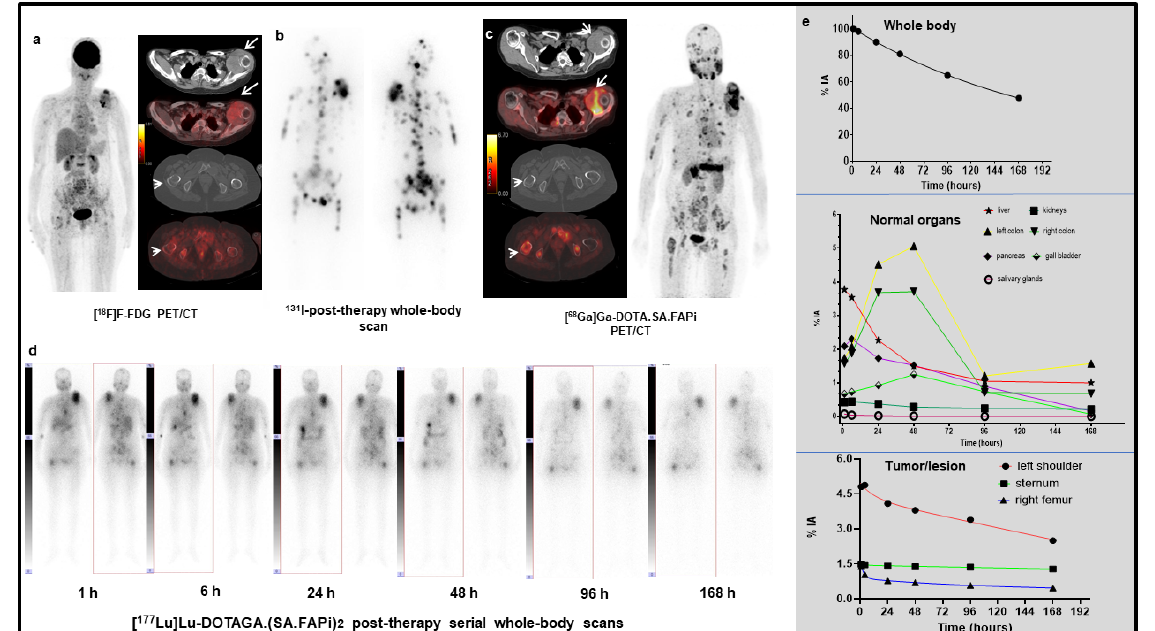
Figure 3. ( a ). [ 18 F]F-Fluorodeoxyglucose (FDG) PET/CT images of a 50-year-old woman with follicular variant of papillary carcinoma, post radioiodine therapy (cumulative dose of 22.2 GBq) showing soft tissue density mass in left shoulder (ar- rows) and multiple skeletal lesions. ( b ). Whole body scintigraphy conducted after additional 7.4 GBq of radioiodine ther- apy, showing multiple foci of tracer accumulation suggestive of disease progression, who was started on Sorafenib (400 mg OD). ( c ). [ 68 Ga]Ga- DOTA.SA.FAPi PET/CT images (performed after 6 months of Sorafenib therapy as part of ongoing